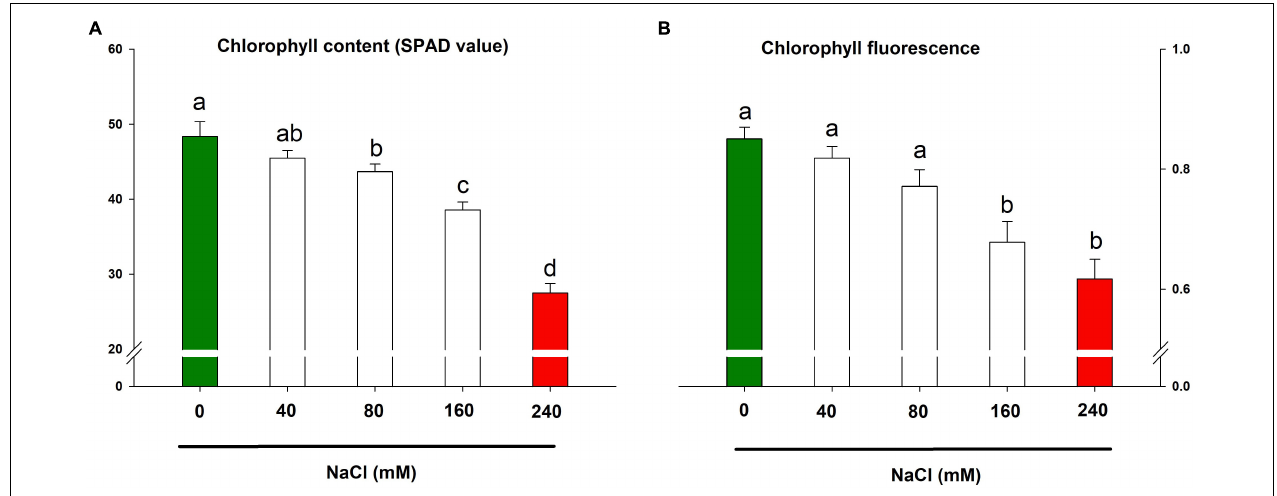
FIGURE 4 | Impact of NaCl concentrations (0, 40, 80, 160, and 240 mM) on chlorophyll content (A) and maximum quantum efficiency of PSII photochemistry (B) of lemongrass plants. Each bar represents mean ± SE ( n = 3). Means followed by the same letter(s) do not differ by LSD test at 5% probability level ( α = 0.05). The colors are just visual ques for readers to quickly distinguish between control and most stressed